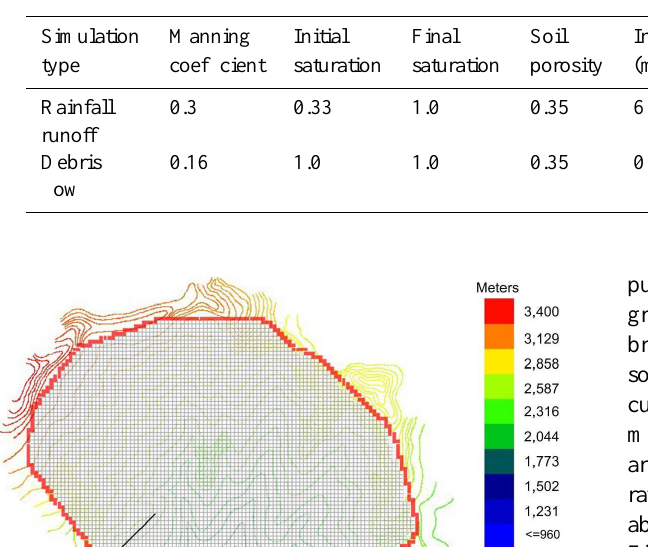
Table 4. Hydrological parameters for rainfall-runoff and debris flow runout simulations in field application.